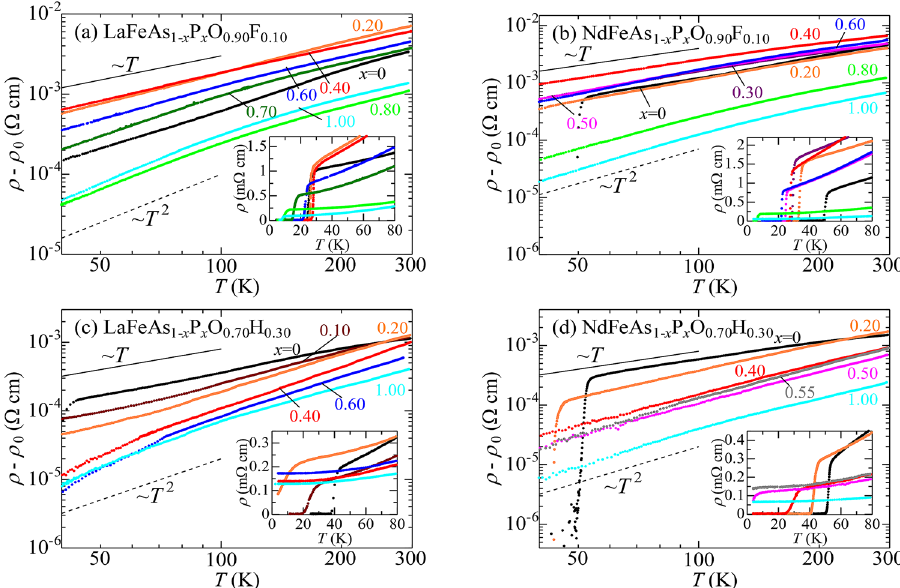
Figure 2. Temperature ( T -) dependence of ρ − ρ 0 for R FeAs 1 − x P x O 0.90 F 0.10 and R FeAs 1 − x P x O 0.70 H 0.30 ( R = La and Nd), where ρ 0 is residual resistivity. ( a ) LaFeAs 1 − x P x O 0.90 F 0.10 . ( b ) NdFeAs 1 − x P x O 0.90 F 0.10 . ( c ) LaFeAs 1 − x P x O 0.70 H 0.30 . ( d ) NdFeAs 1 − x P x O 0.70 H 0.30 . Insets of ( a – d ) show T -dependence of resistivity ρ at low temperatures. T -dependence of ρ for other compositions are shown in Supplementary Information (Figs. S2 and S3).